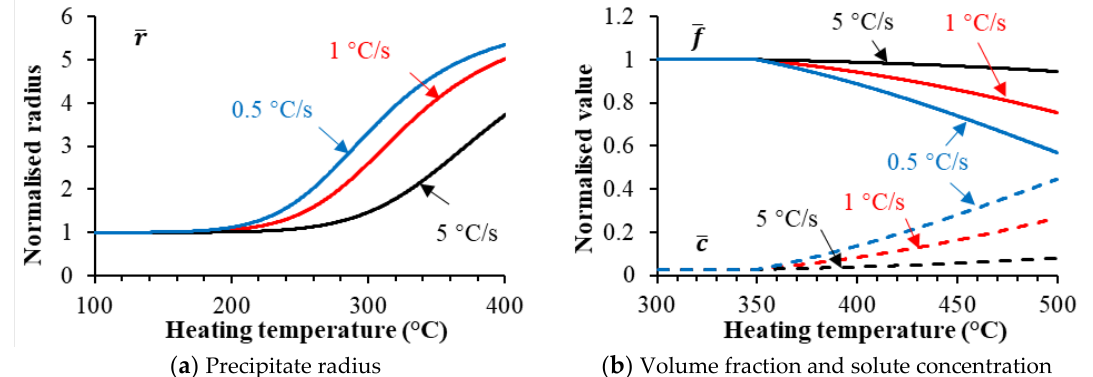
Figure 6. Modeling results of evolution of key microstructures during heating of AA7075-T6 with indicated heating rates: ( a ) precipitate radius and ( b ) volume fraction and solute concentration.